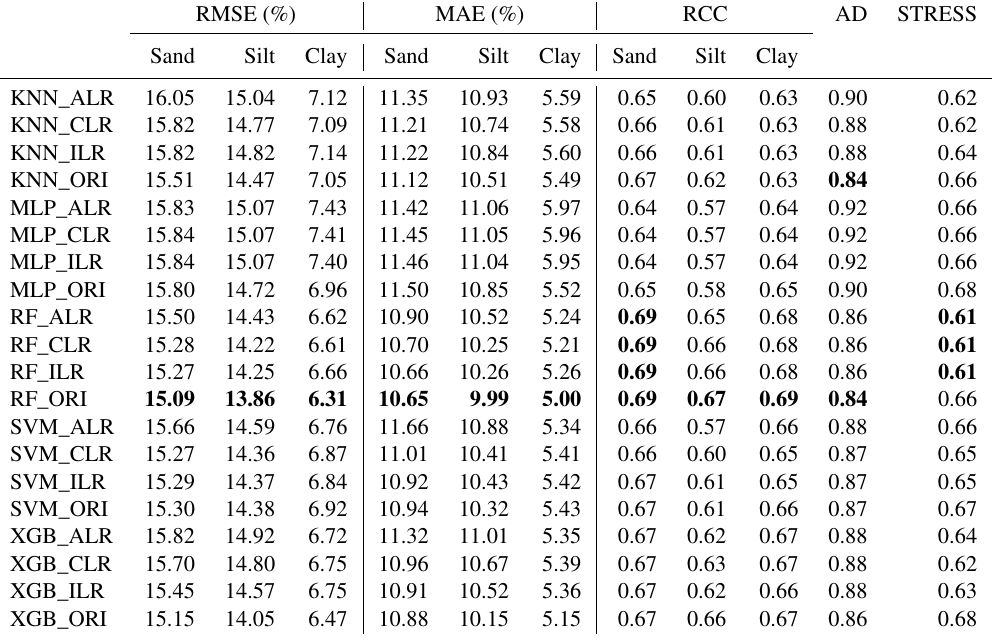
Table 2. Comparisons of the accuracy of different machine-learning models combined with original and transformed data. Bold values denote the best model performance for different